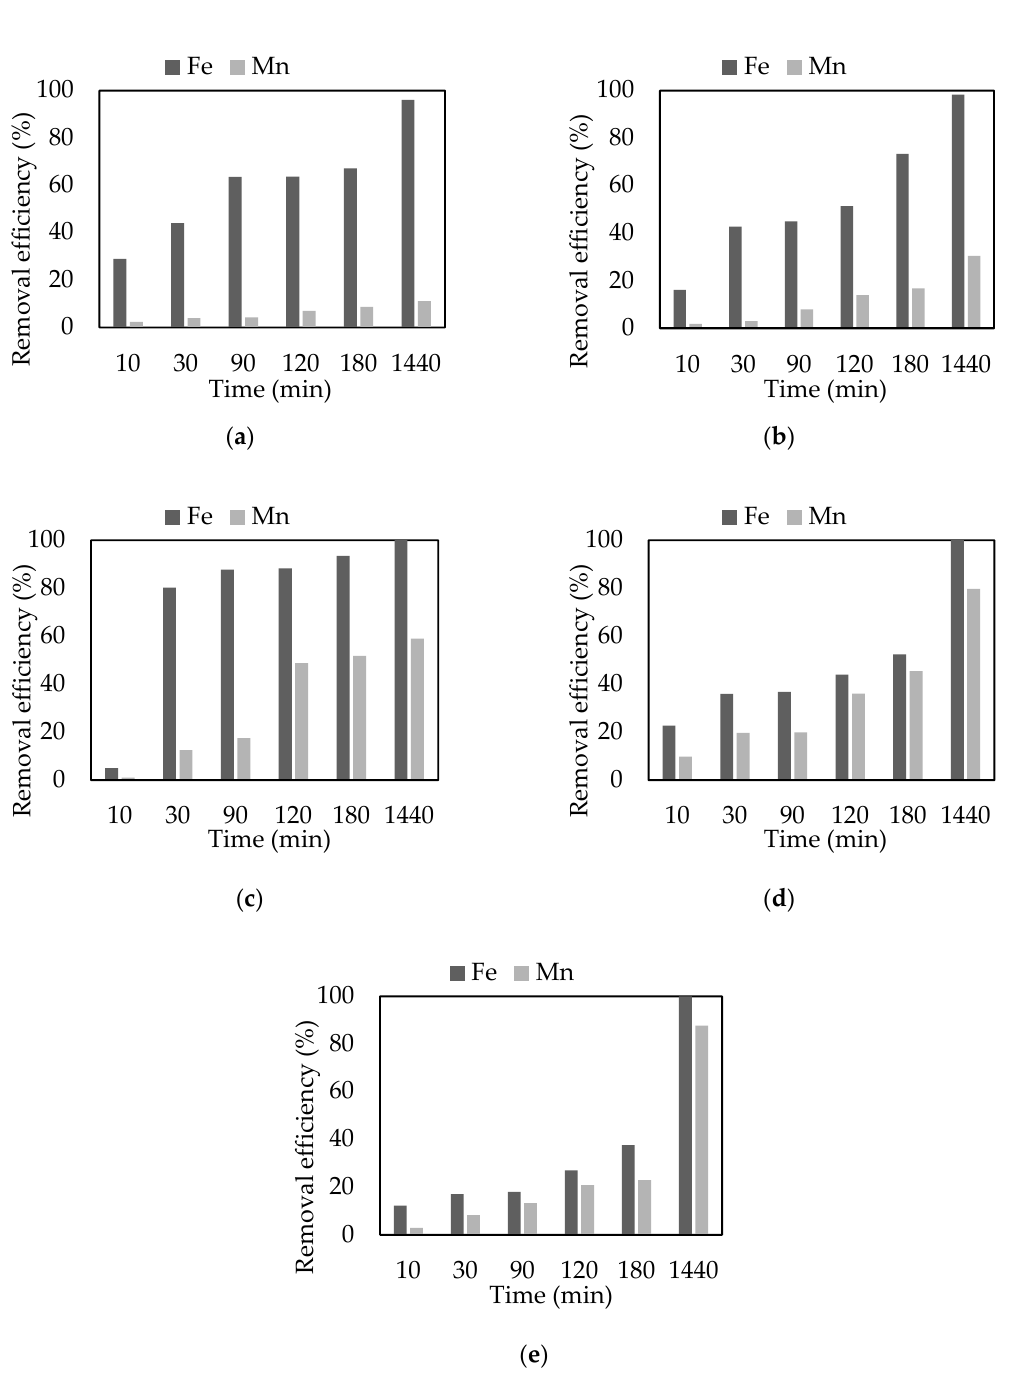
Figure 2. Simultaneous removal of Fe and Mn by di ff erent quantities of NZ 200: 0.5 g ( a ), 1 g ( b ), 2 g ( c ), 3 g ( d ), 4 g ( e ); C o = 45/25 mg/L Fe/Mn; V = 100 mL; 100 rpm; 23 ± 2 °C.